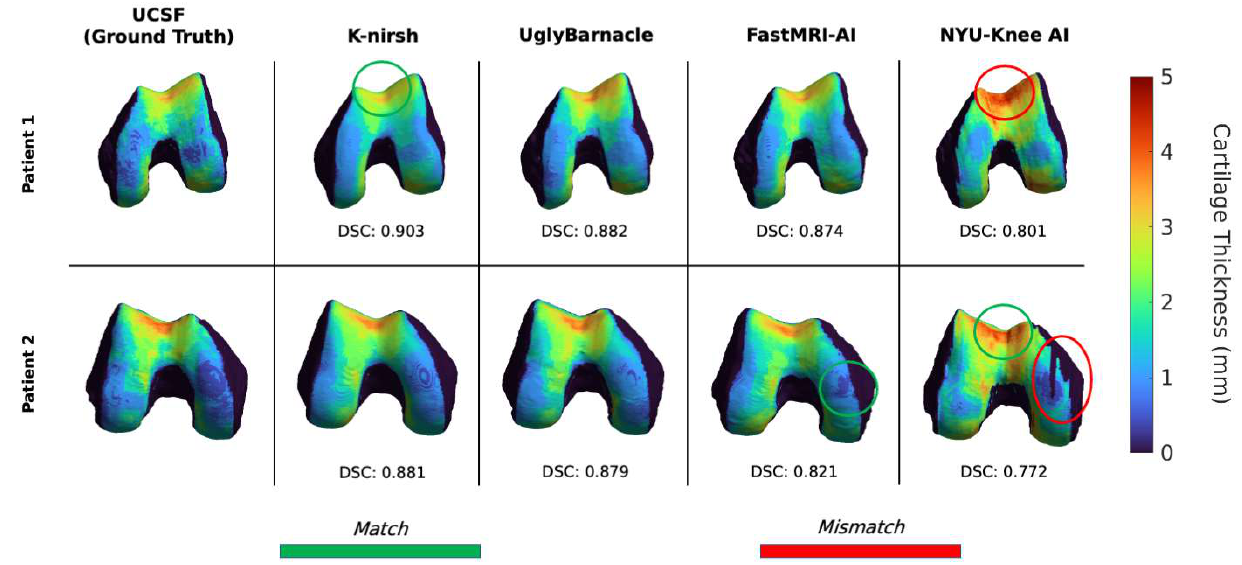
Figure 9. Femoral cartilage thickness maps projected onto voxel-based femoral bone shapes for each of the top 4 teams, as well as ground truth. While all submissions exhibit a degree of smoothness that is not reflected in the ground truth, the top three especially were strong in preserving cartilage thicknesses (K-nirsh, UglyBarnacle, FastMRI-AI), with NYU-Knee AI slightly overestimating cartilage thicknesses but still preserving key features in some regions.